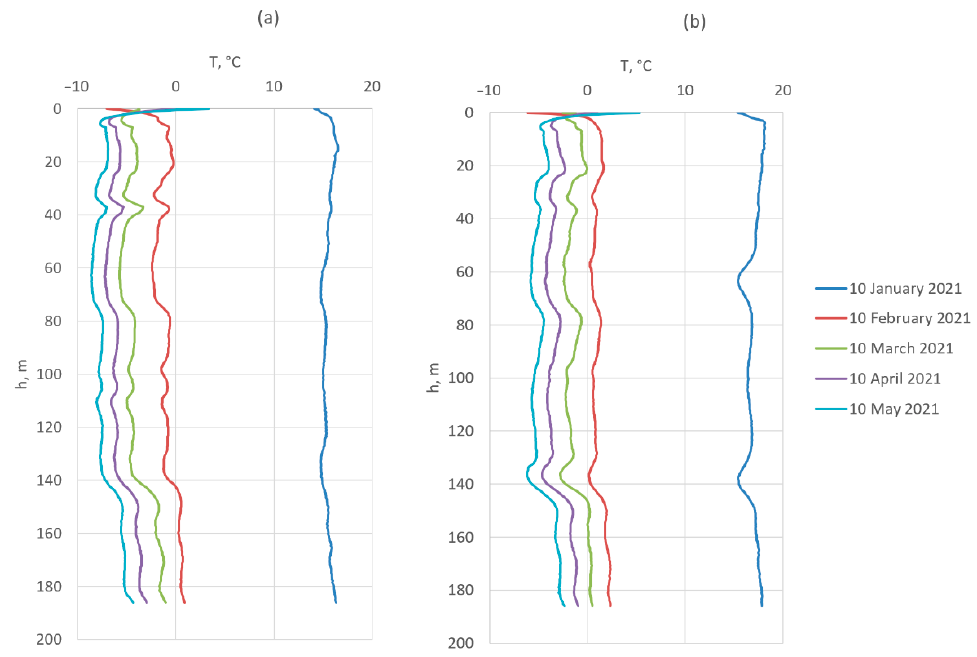
Figure 1. Temperature distributions over the depth of two TC boreholes at different time points; TC-1 ( a ) and TC-2 ( b ).